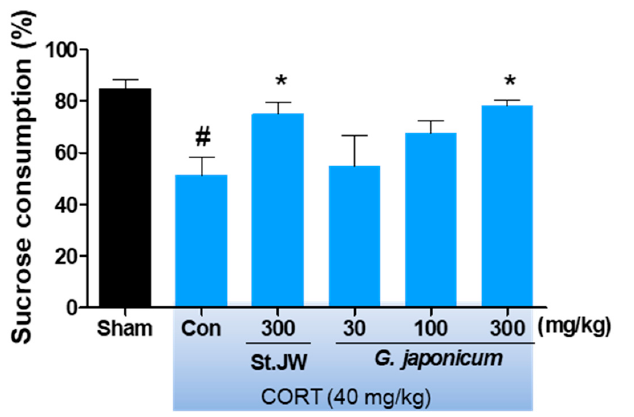
Figure 3. Effects of G. japonicum extract on sucrose consumption in CORT-induced depressive mice. CORT injections significantly decreased sucrose consumption, while treatment with 300 mg/kg G. japonicum extract significantly increased it. Results are presented as mean ± SEM. # p < 0.05 versus the sham group; * p < 0.05 versus the CORT-injected control group (Con).